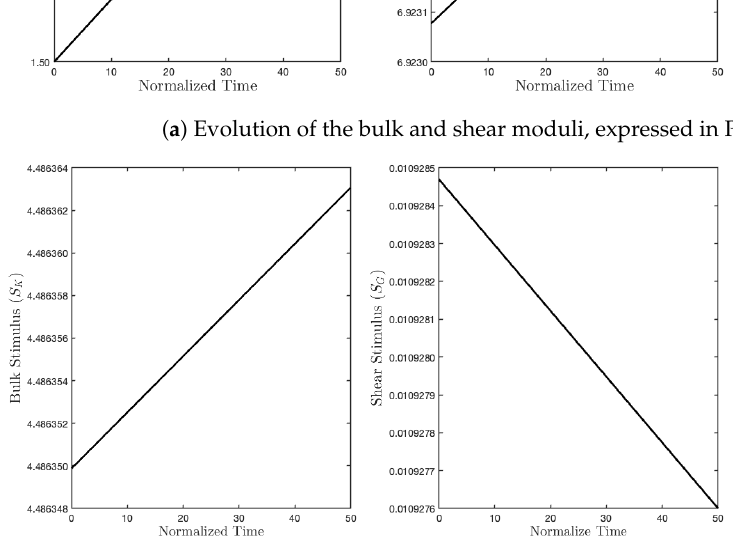
( b ) Evolution of the bulk and shear stimulus, expressed in N. Figure 11. Evolution of moduli and stimuli in time for the tensile